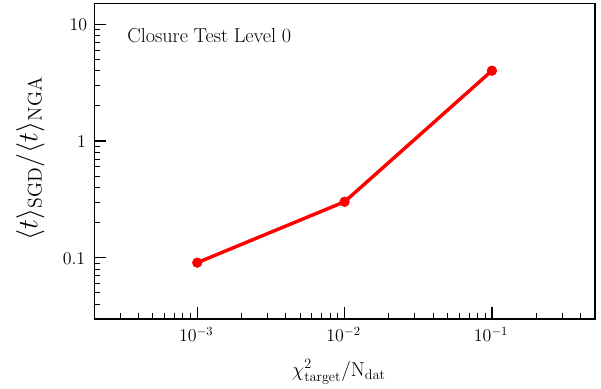
Fig. 6 Benchmark comparison of the performance of the TensorFlow -based stochastic gradient descent optimization with that of the Genetic Algorithm used in most of the previous NNPDF fits. The ratio of the average SGD time over the average NGA time is plotted as a function of the χ 2 target / N dat for a Level 0 closure test